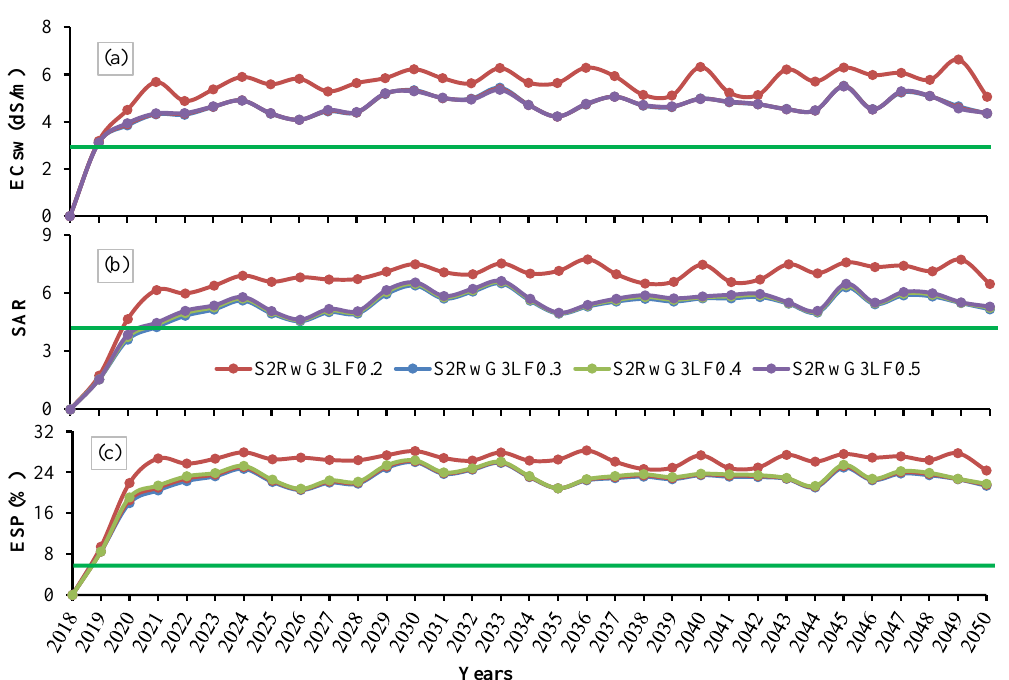
Figure 12. Impact of different leaching fractions (LF0.2, LF0.3, LF0.4, and LF0.5) and annual gypsum applications of 8.6 t/ha (G3) on ( a ) EC sw , ( b ) SAR, and ( c ) ESP in the 0–15 cm soil layer of the hard red-brown soils (S2) under recycled water (RW) irrigation of almonds.